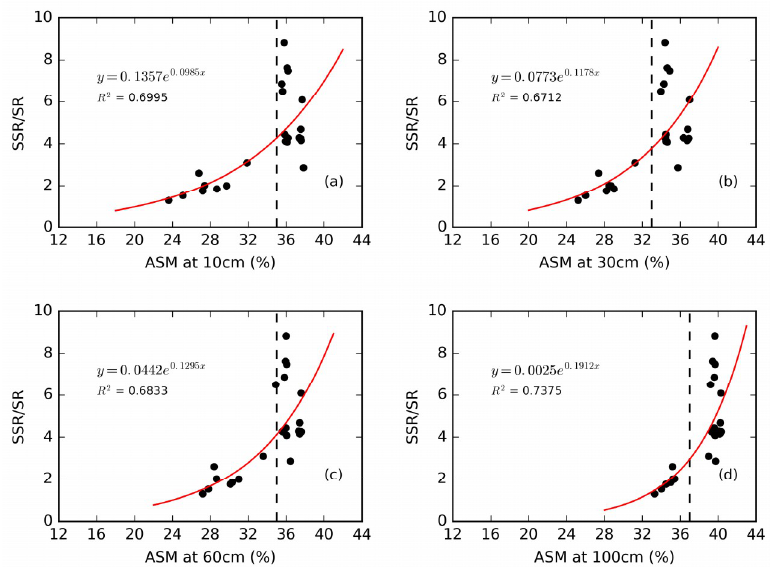
Figure 8. Relationship between the ratio of subsurface runoff to surface runoff (SSR/SR) and ASM (Antecedent Soil Moisture) at different depths: ( a ) 10 cm; ( b ) 30 cm; ( c ) 60cm; ( d ) 100 cm. The vertical line highlights the significant change.